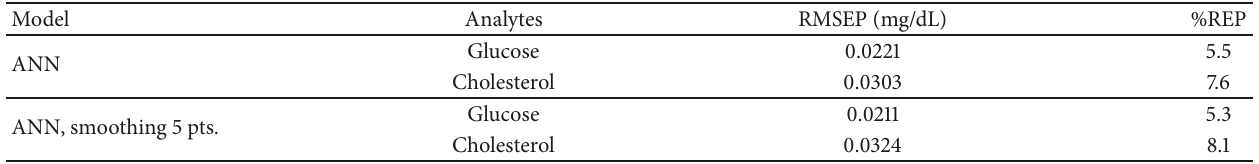
Table 5: Errors obtained between nominal concentrations and estimated by